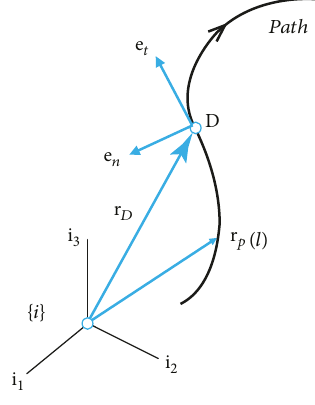
Figure 1: Parametric representation of a general